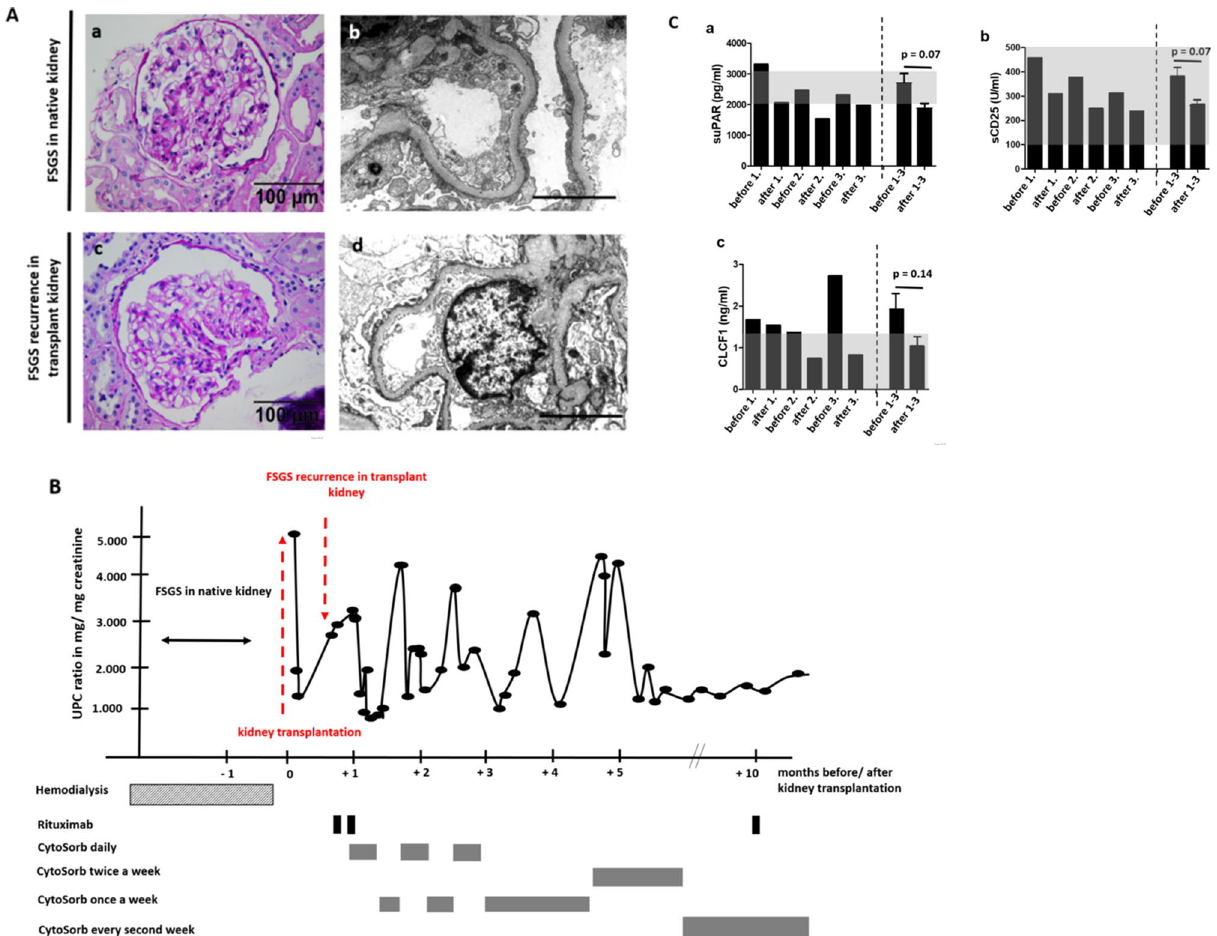
Figure 1. CytoSorb apheresis to treat therapy resistant and early recurrent FSGS. ( A )—(a) PAS staining of native kidney biopsy of the patient at the time of initial diagnosis of FSGS. Scale bar = 100 µm. (b) Transmission electron microscopy picture of native kidney biopsy of the patient at the time of initial diagnosis of FSGS. Scale bar = 1 µm. (c) PAS staining of transplant kidney biopsy of the patient at the time of the diagnosis of recurrence of podocytopathy. Scale bar = 100 µm. (d) Transmission electron microscopy picture of transplant kidney biopsy of the patient at the time of the diagnosis of recurrence of podocytopathy. Scale bar = 1 µm. ( B ) Illustration of clinical course of the patient. Proteinuria measured as urine-protein-creatinine-ratio (UPC-ratio) is given in black dots and lines. Time points of kidney transplantation, transplant kidney biopsy, Rituximab treatment and CytoSorb apheresis schedule are illustrated. ( C ) Measurements for suPAR (a), sCD25 (b) and CLCF1 (c) in serum samples of the patient before and after first, second and third CytoSorb apheresis. The last two columns depict the mean of measurements for the parameters before and after apheresis 1–3. Normal reference levels are shown in gray. Differences before and after CytoSorb apheresis were not significant for suPAR, CLCF1 and